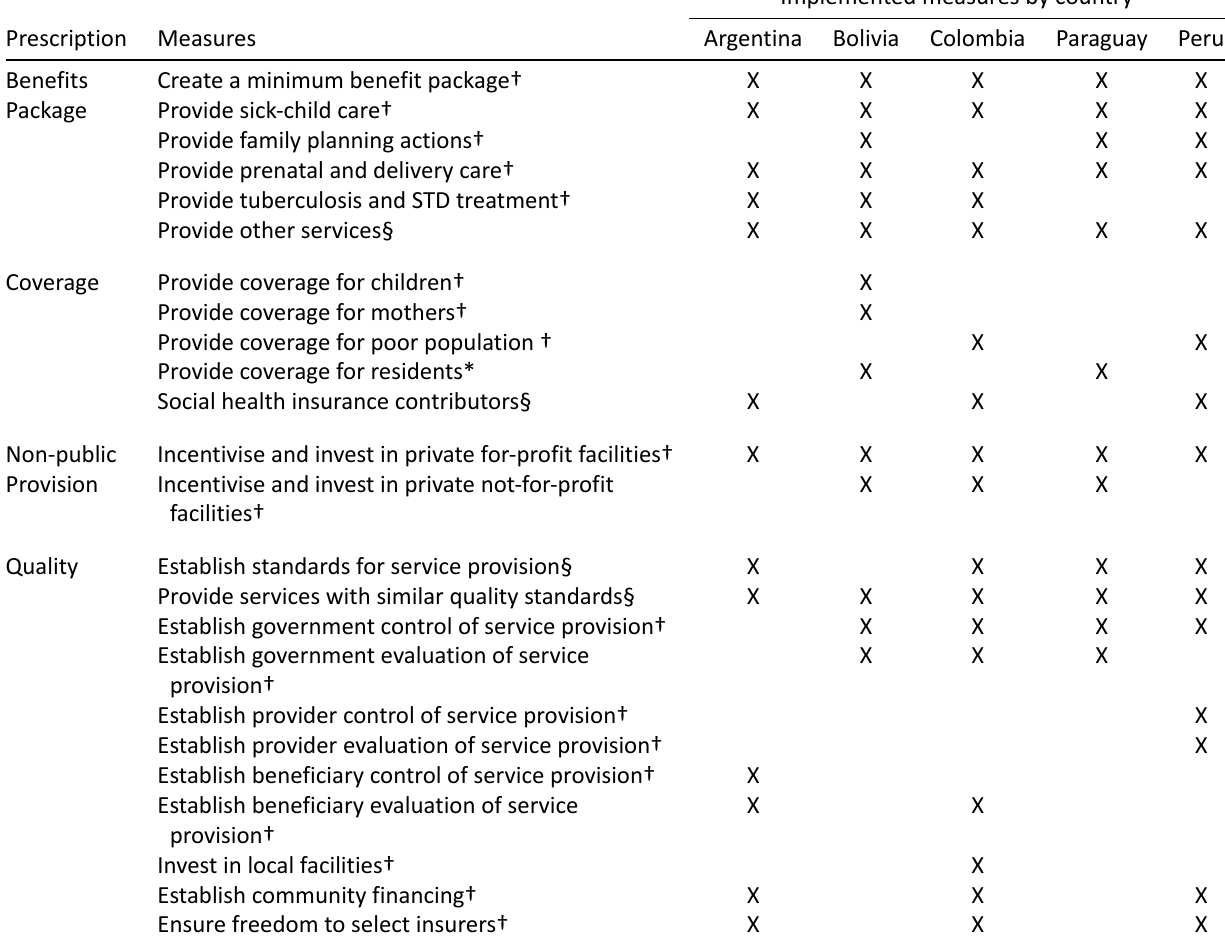
Table 6. Service provision